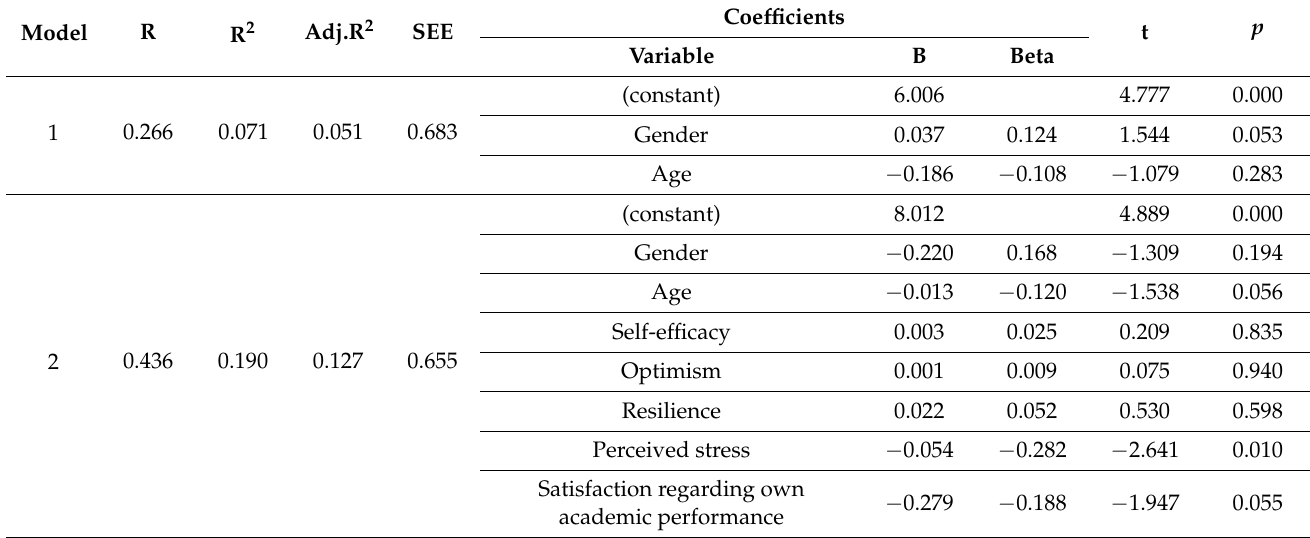
Table 5. Determinants of academic performance for clinical students. ( N = 97) (linear regression).